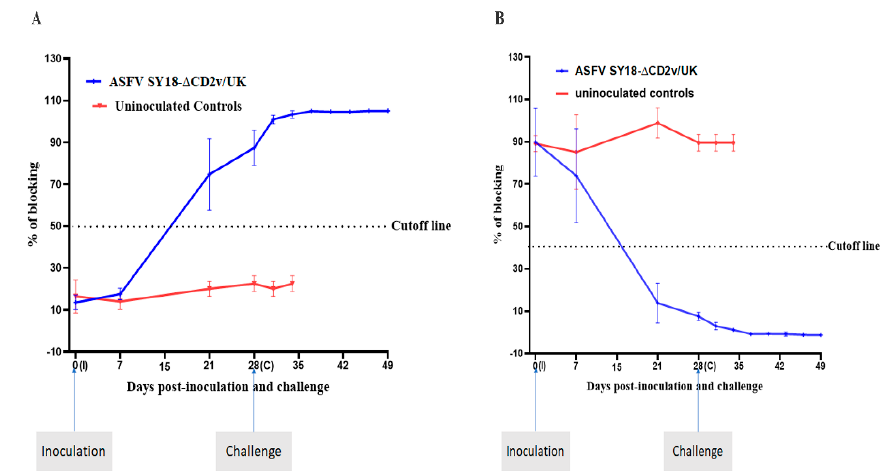
Figure 4. Detection of ASFV ‐ specific antibodies in the pigs inoculated with ASFV ‐ SY18 ‐∆ CD2v/UK. ( A ) Anti ‐ p72 antibodies were detected using a blocking ELISA from the collected serum samples. Serum samples with a blocking percentage of ≥ 50% were considered positive. ( B ) Anti ‐ p30 antibodies were detected using a blocking ELISA. Serum samples with a blocking percentage of ≤ 40% were group on the indicated days. The error bars represent the standard